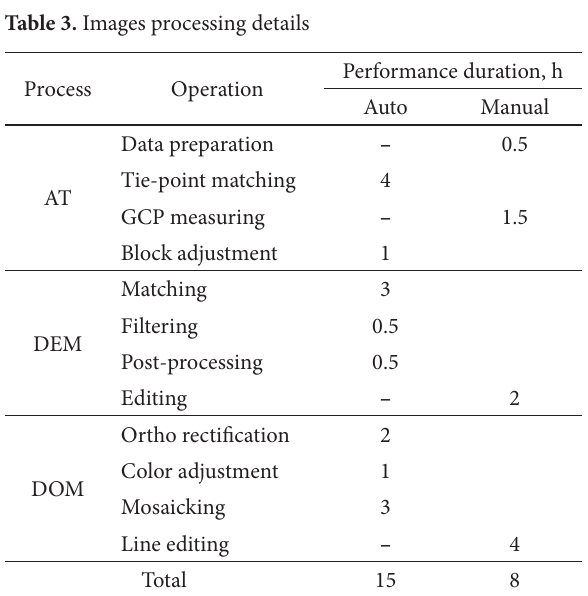
Table 3. Images processing details